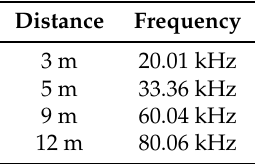
Table 2. The distance and